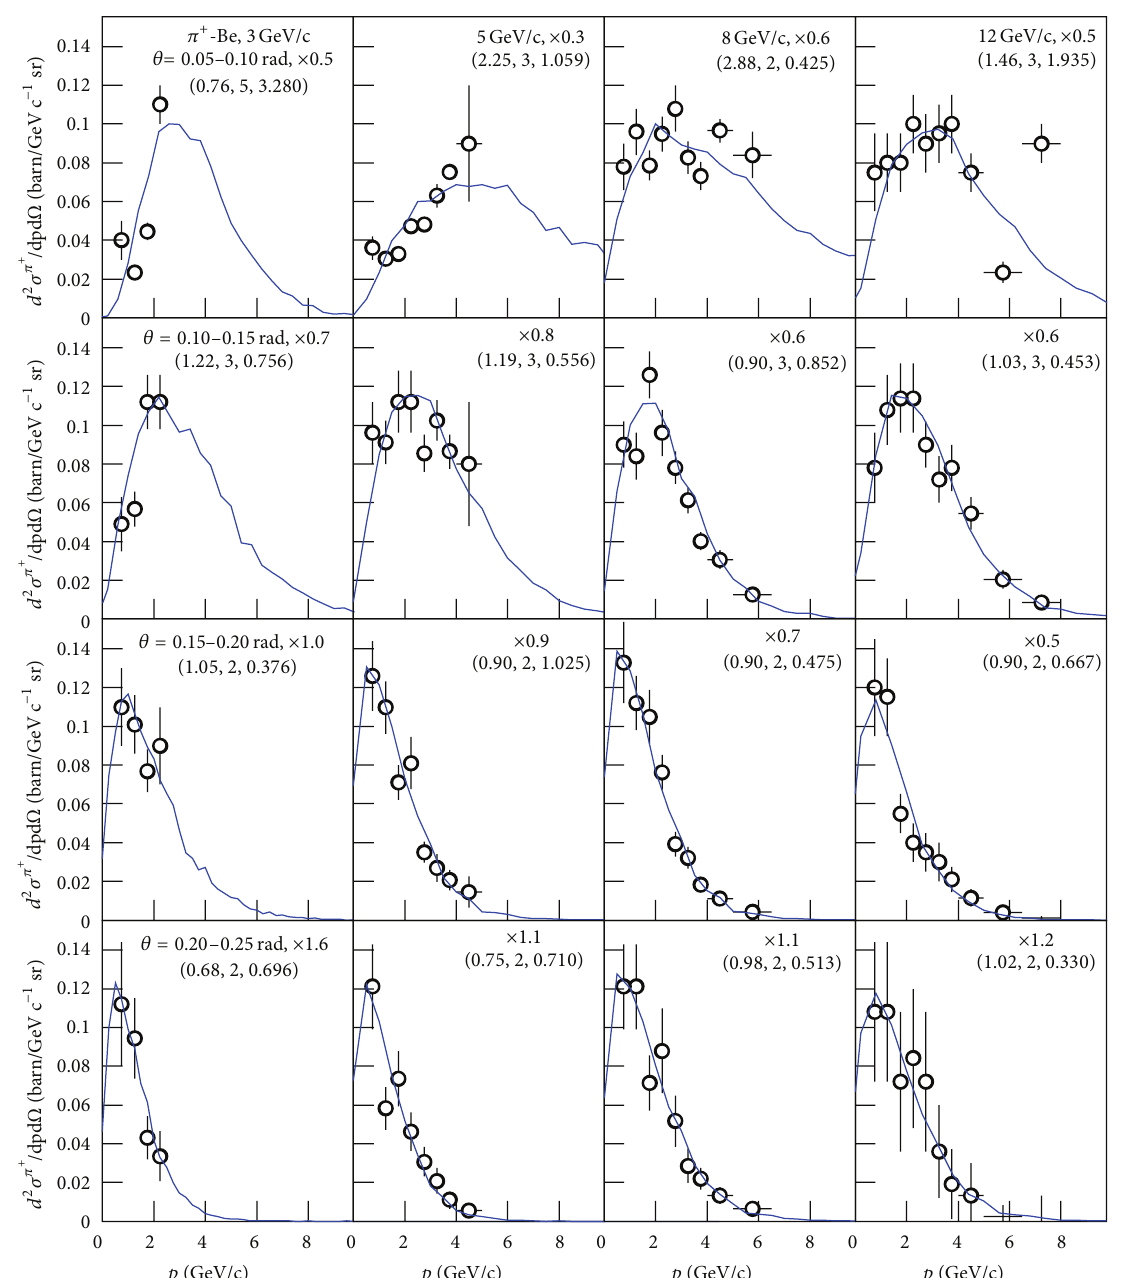
Figure 3: The same as Figure 1, but showing the results in 𝜋 + -Be